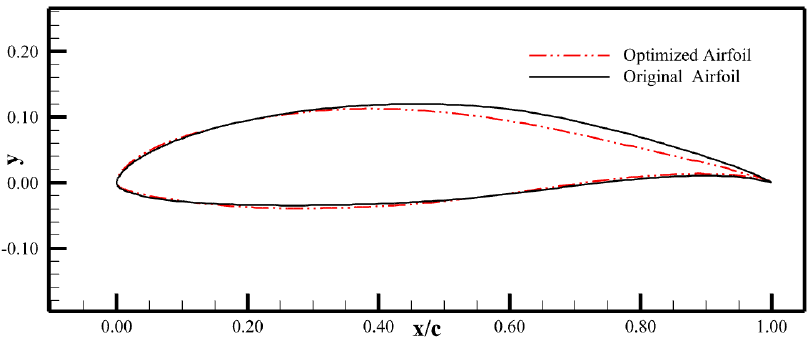
Figure 18. Comparison of airfoils before and after robust optimization after robust optimization based on uniform probability distribution. based on uniform probability